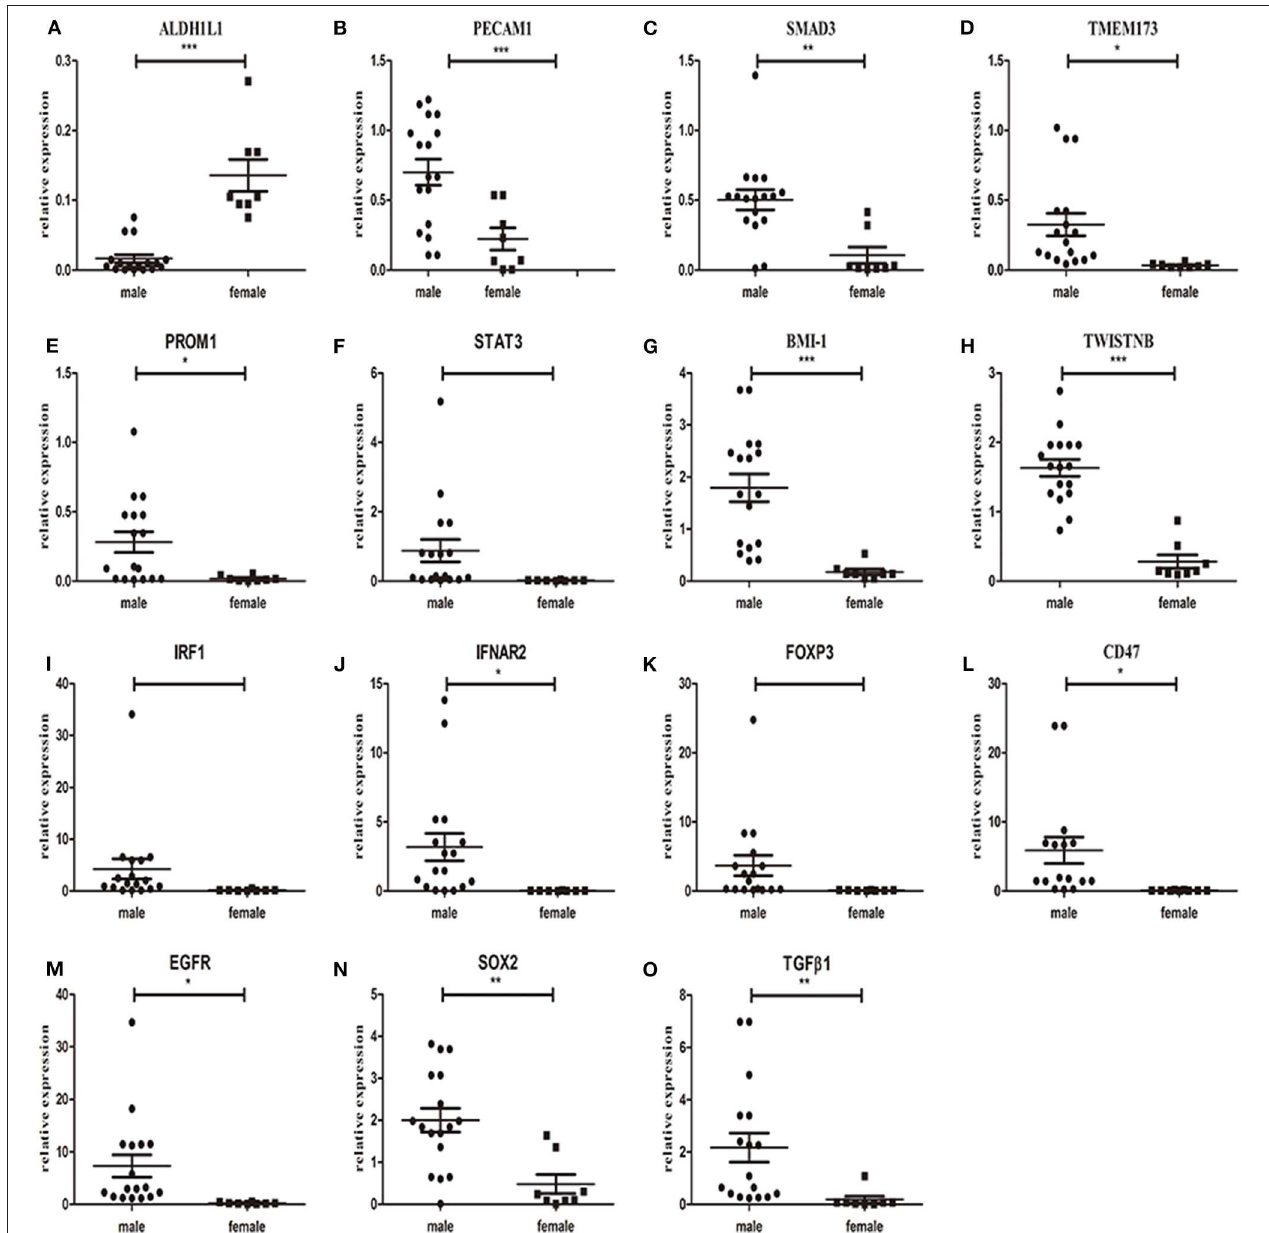
FIGURE 3 | mRNA expression of ALDH1L1 (A) , PECAM1 (B) , SMAD3 (C) , TMEM173 (D) , PROM1 (E) , STAT3 (F) , BMI-1 (G) , TWISTNB (H) , IRF1 (I) , IFNAR2 (J) , FOXP3 (K) , CD47 (L) , EGFR (M) , SOX2 (N) , and TGF β 1 (O) in the primary of tumor samples between male and female patients. * P < 0.05, ** P < 0.01, *** P <